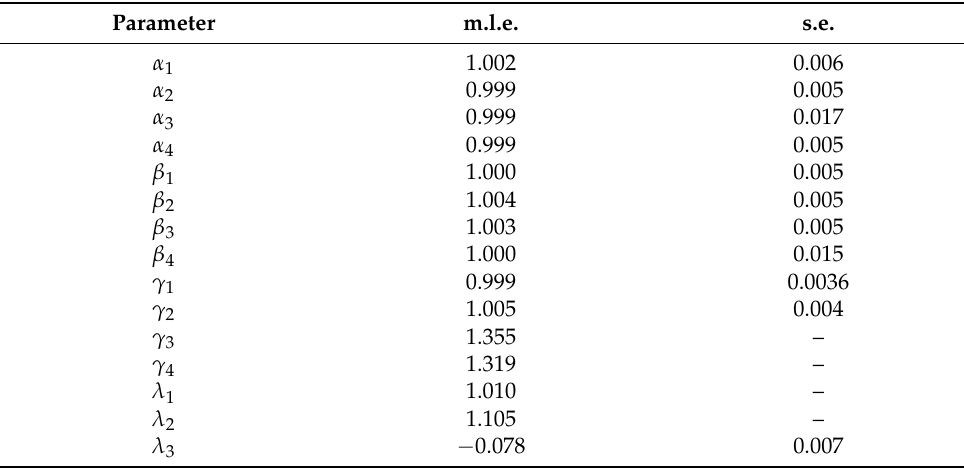
Table 5. Final model estimates and its standard error (s.e.) Road safety